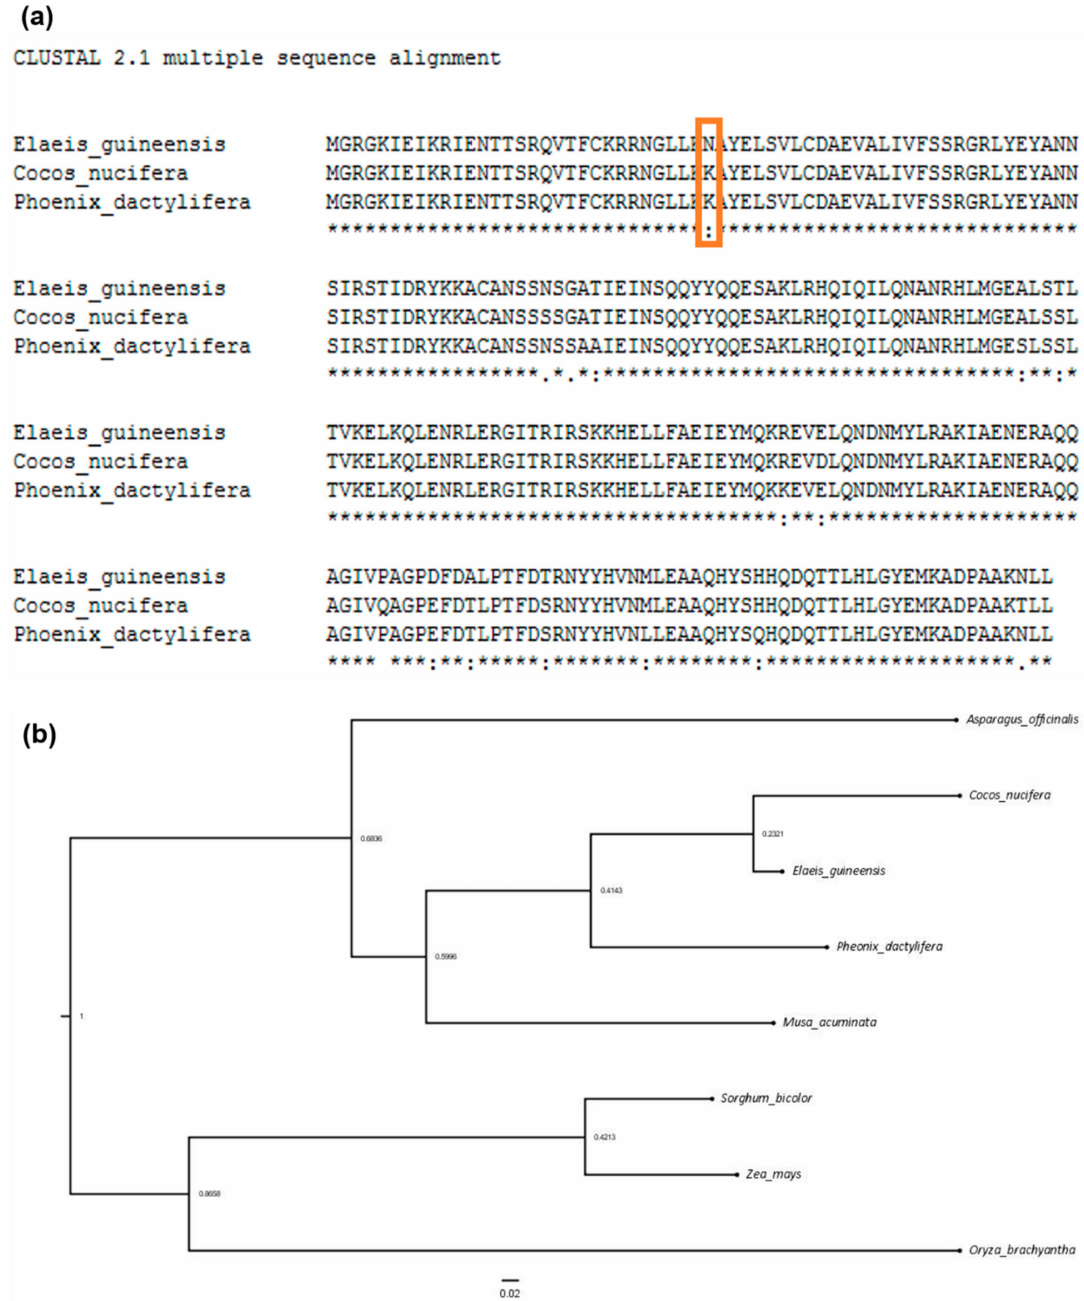
Figure 3. High conservation of genes among palm species with minimal amino acid changes. ( a ) Alignments of SHELL gene encoding for the layer of shell surrounding the kernel for oil palm and the orthologues from coconut and date palm. ( b ) Phenogram tree for LOG gene orthologues, which play a role in sex determination for date palms; orthologues of the gene among palms and other monocots outgroup taxa were